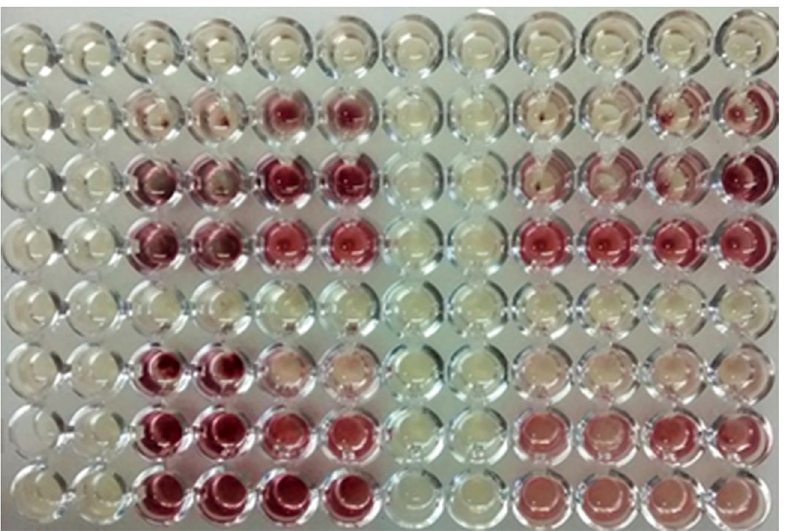
Figure A2: Assessment of bacterial viability via chromogenic staining with INT ( 4% w/v ) , in 96 - well microplates. The transformation to formazan color ( red color ) indicates viable